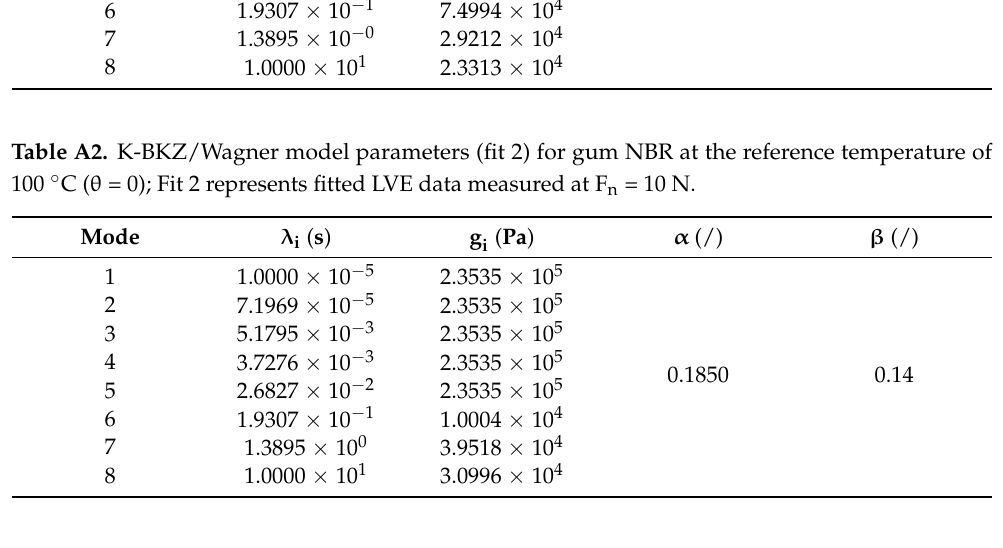
Table A3. K-BKZ/Wagner model parameters (fit 3) for gum NBR at the reference temperature of